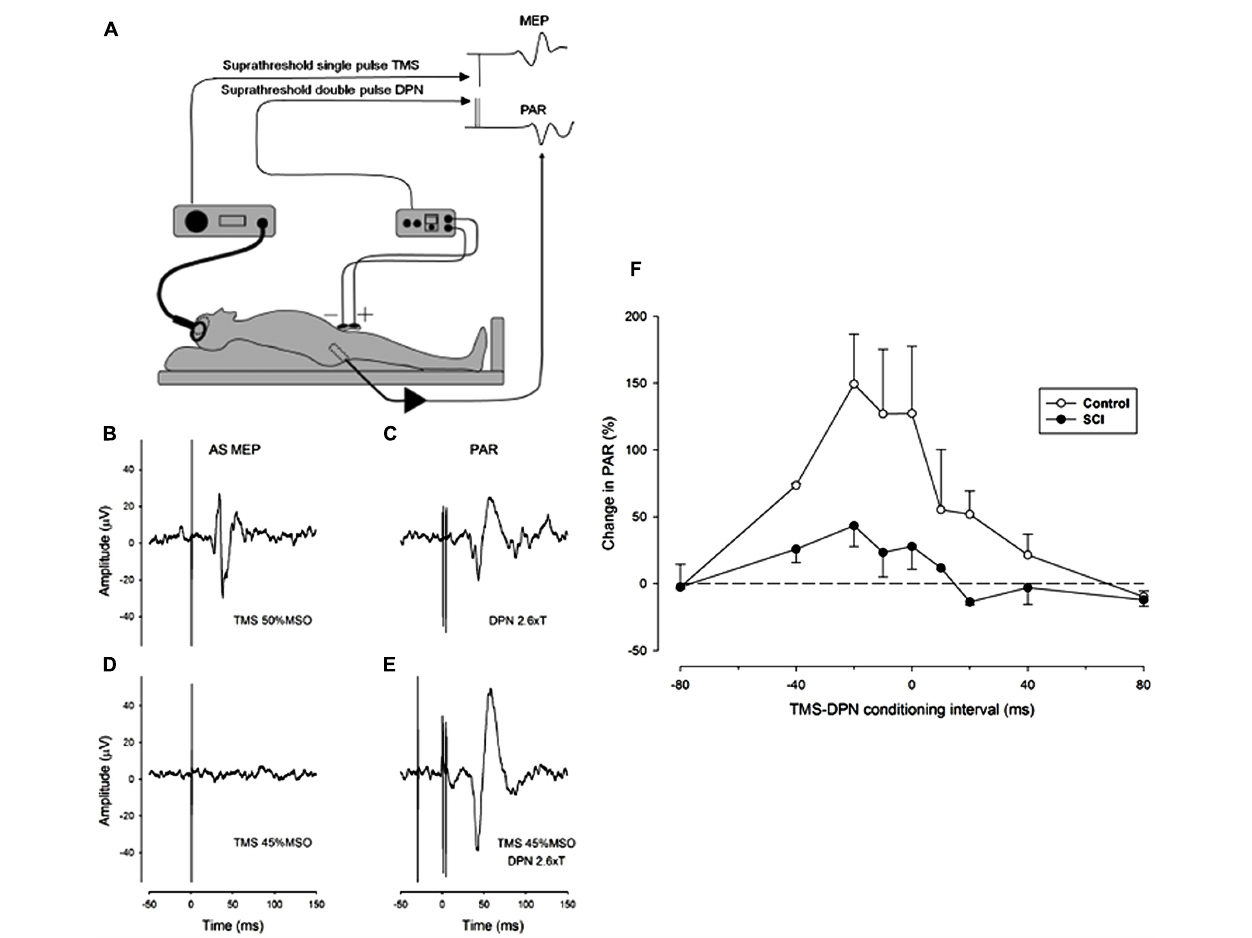
FIGURE 1 | Facilitation of the pudendal anal reflex (PAR) by single pulse transcranial agnetic stimulation (TMS) of the motor cortex. (A) Experimental set-up showing position of dorsal penile nerve stimulating electrodes (DPN), anal sphincter EMG recording electrode and the TMS double cone coil. Insets: idealized PAR and anal sphincter motor evoked potential (MEP) responses. (B − E) Anal sphincter EMG averaged ( n = 10) evoked responses in a control subject. (B) MEP to cortical TMS at 50% maximum stimulator output (MSO). (C) PAR response to stimulation of the DPN at 2.6 times sensory threshold (18 mA). (D) Lack of response to TMS at 45% MSO. (E) TMS at 45% MSO preceding DPN